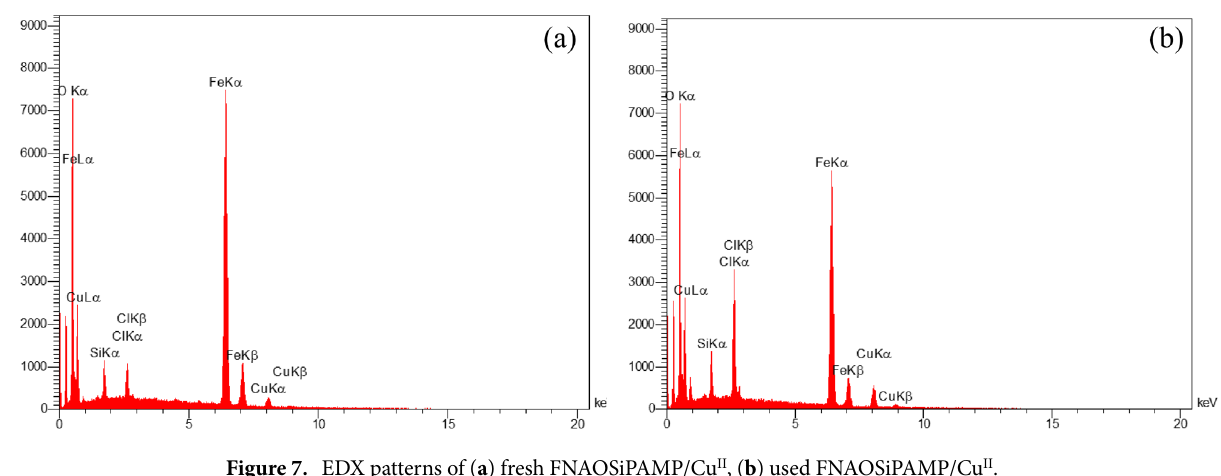
Figure 7. EDX patterns of ( a ) fresh FNAOSiPAMP/Cu II , ( b ) used FNAOSiPAMP/Cu II